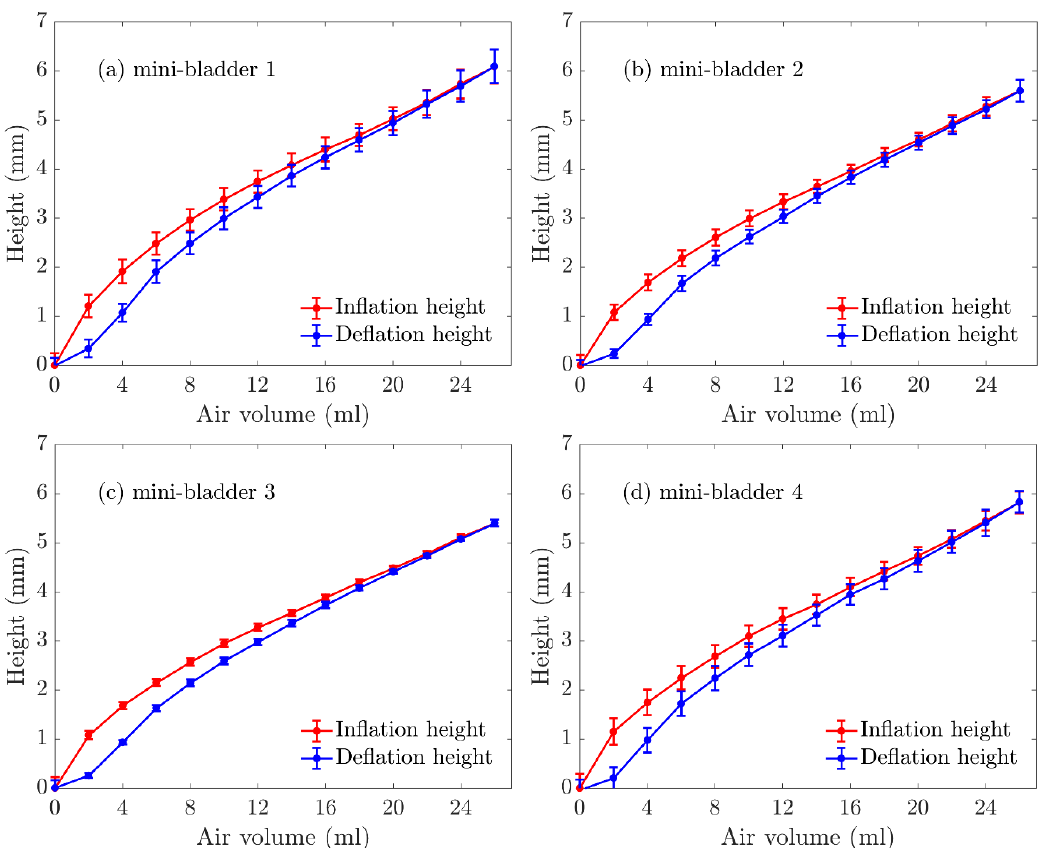
Figure 5. Experimentally measured inflation deflation height (average) of mini-bladder unit of 4 hexagonal mini-bladders made of PlatSil ® Gel-OO. ( a ) mini-bladder 1, ( b ) mini-bladder 2, ( c ) mini-bladder 3, ( d ) mini-bladder 4.